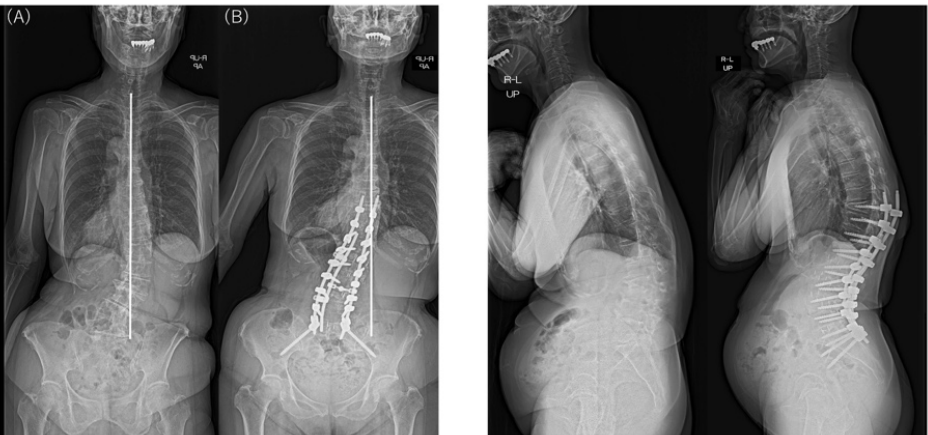
Figure 5. Preoperative and postoperative standing radiographs showing worsened CM after surgery in a 75-year-old woman with type 2 CM. CBD worsened from 38.1 mm preoperatively ( A ) to 67.7 mm postoperatively ( B ), with the C7 plumb line on the same side as the CBD. Sagittal alignment improved, but proximal junctional kyphosis was noted postoperatively.